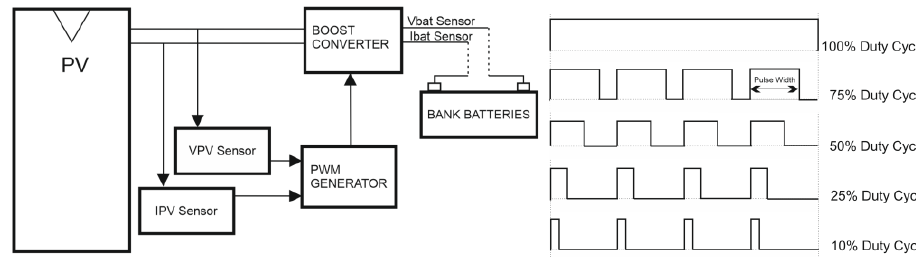
Figure 1. PWM solar charge regulators.